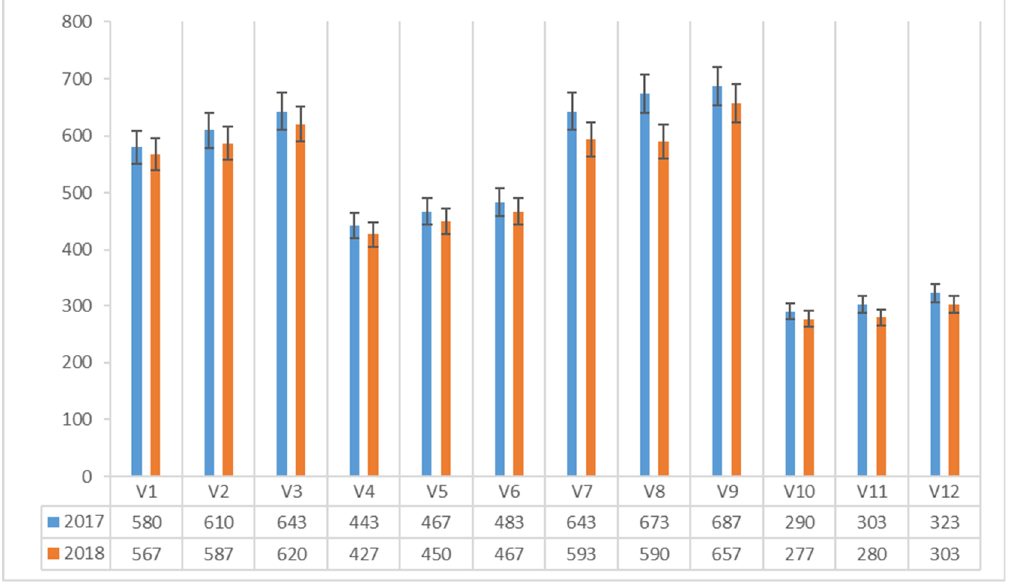
Figure 5. Vitamin B 9 content of Agaricus blazei Murrill mushrooms ( µ g 100 g − 1 dm) in two years of experiments.